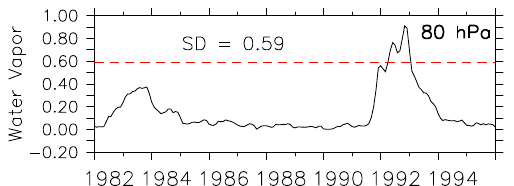
Figure 8. Differences (VOL-NOVOL) in water vapour (ppmv) for the tropics (5 ◦ S–5 ◦ N), zonally averaged after the March 1982 El Chichón and the June 1991 Mount Pinatubo eruption for the 80hPa level. The red dashed line indicates the standard deviation (ppmv) for the unperturbed NOVOL simulation in the same region, calcu- lated over the whole time series of 1979–2013.